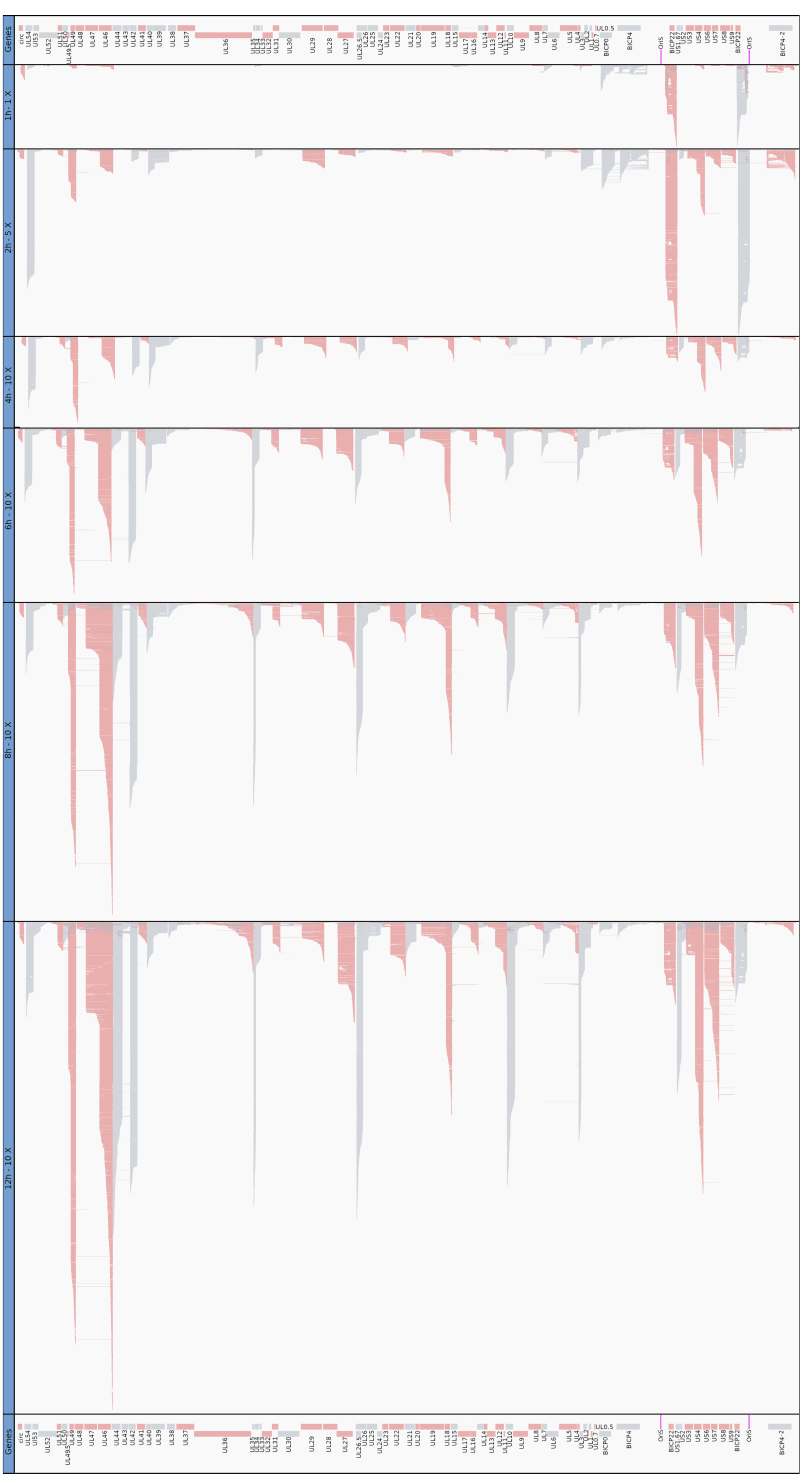
Figure 9. Genome-wide expression dynamics of BoHV-1 transcription. Viral transcripts were ana- lyzed at six time points (1, 2, 4, 6, 8, and 12 h) throughout the viral infection. The average of the three biological replicates was depicted using IGV 2.7.2 . Red color indicates a left to right (+ strand), whereas gray color a right to left orientation ( − strand) of genes and transcripts. The 1 h sample was not down-sampled, while at the 2 h sample, we applied a twofold and at the other time points a tenfold